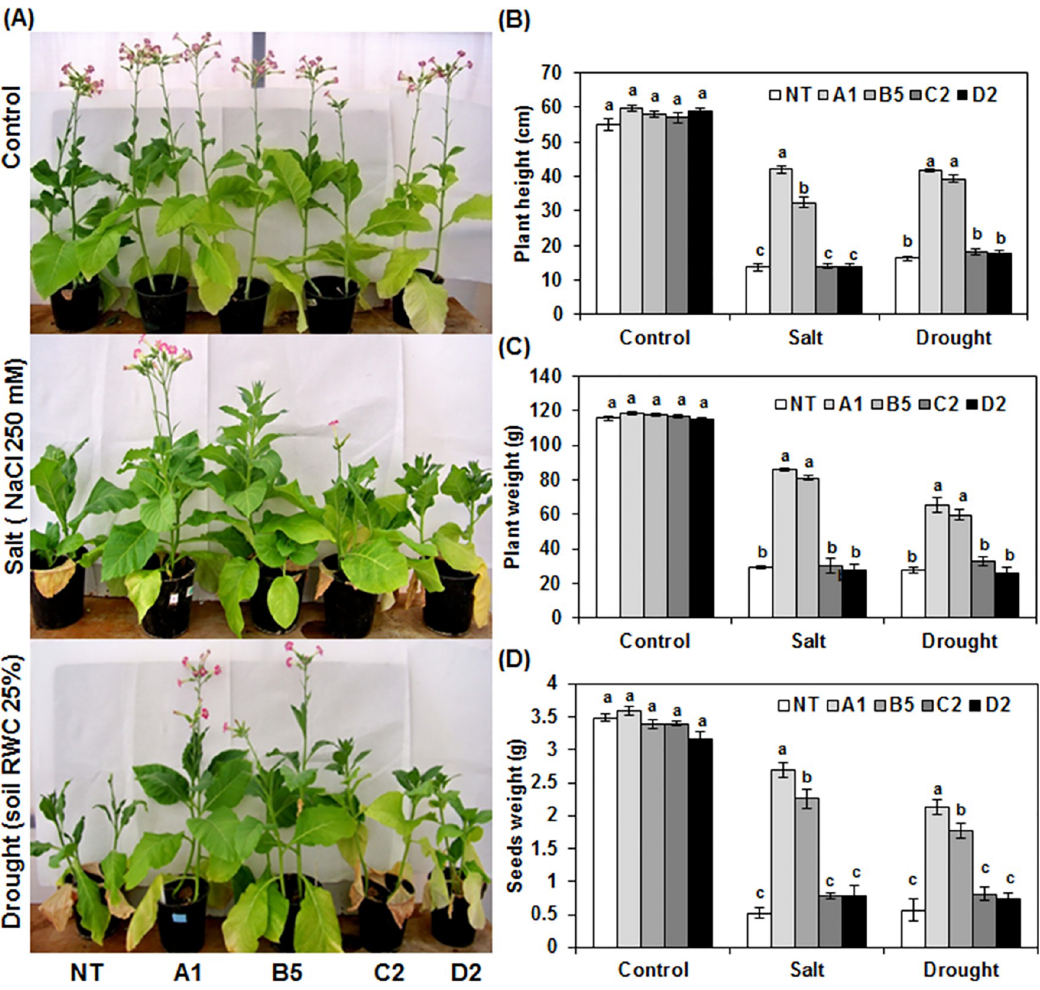
Fig 1. Analysis of salt and drought tolerance of non-transgenic (NT) and LmSAP-FL , LmSAP Δ A20 , LmSAP Δ AN1 , and LmSAP Δ A20- Δ AN1 transgenic tobacco plants (named as A1, B5, C2, and D2, respectively) under greenhouse conditions. ( A ) Phenotypes of NT and transgenic plants grown under normal, salt stress (250 mM NaCl), or drought stress (25% RWC in the soil) conditions until the end of the growth cycle. ( B ) Height of NT and transgenic plants transformed with different constructs measured at end of the growth cycle, ( C ) Plant and ( D ) seed weight (g per plant). Values are means ± SE (n = 3). Means denoted by the same letter did not differ significantly at p <